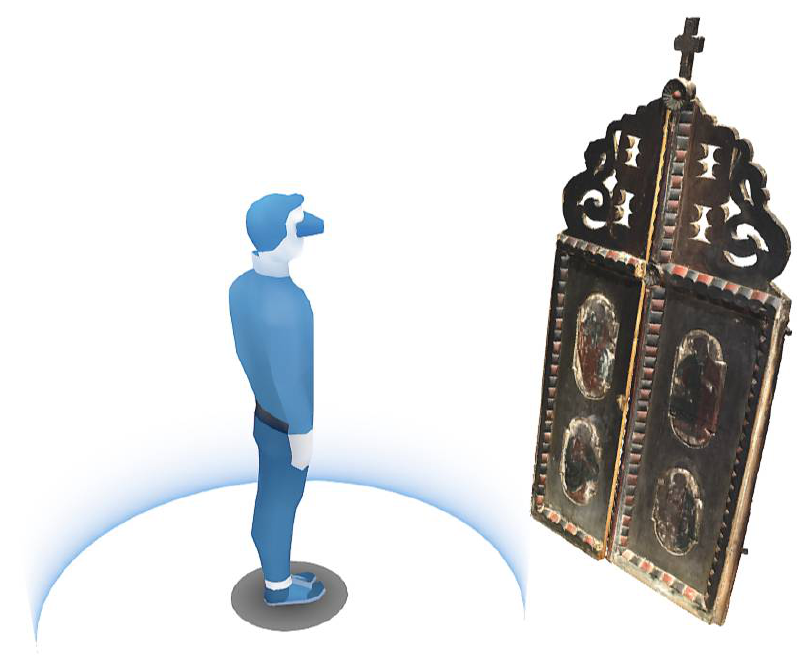
Figure 15. Showcasing the imperial gates using virtual reality.